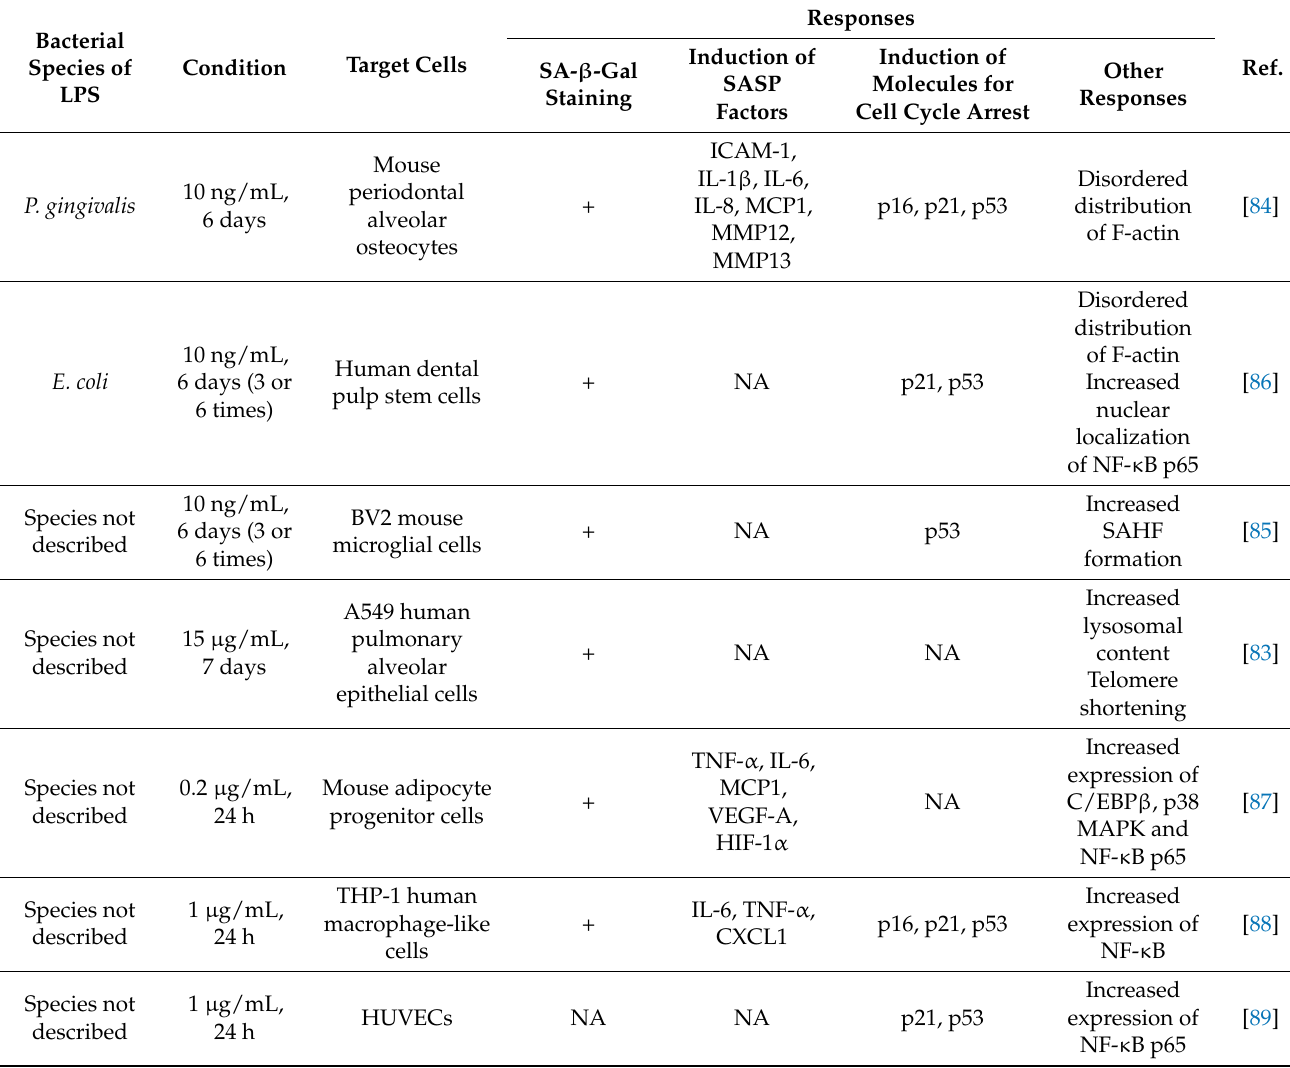
Table 1. Summary of the senescence-inducing action of